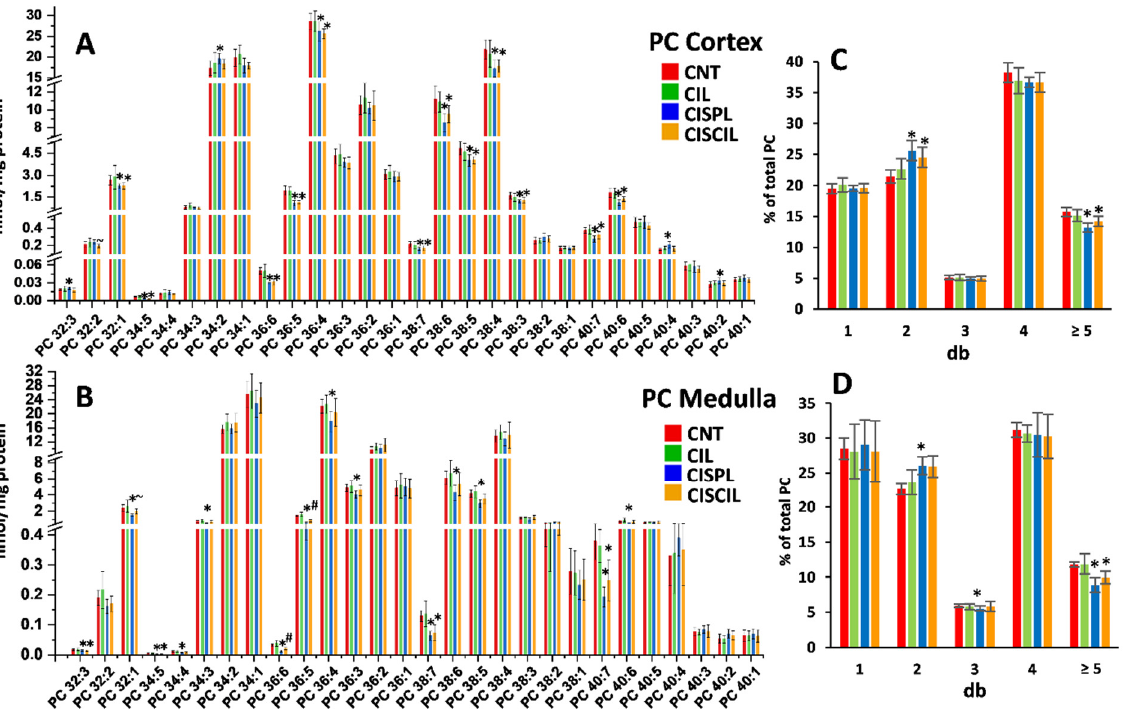
Figure 5. Phosphatidylcholine (PC) species found in the ( A ) cortex and ( B ) medulla in CNT, CIL, CISPL, and CISCIL groups. Percentage of PC species containing different double bonds are presented in the ( C ) cortex and ( D ) medulla. * p < 0.05 vs. CNT. ~ p < 0.05 vs. CISPL. # p < 0.05 vs. CNT and CISPL. FDR < 0.1 was considered. Data are presented as the mean ± sd; n = 6 animals per group.